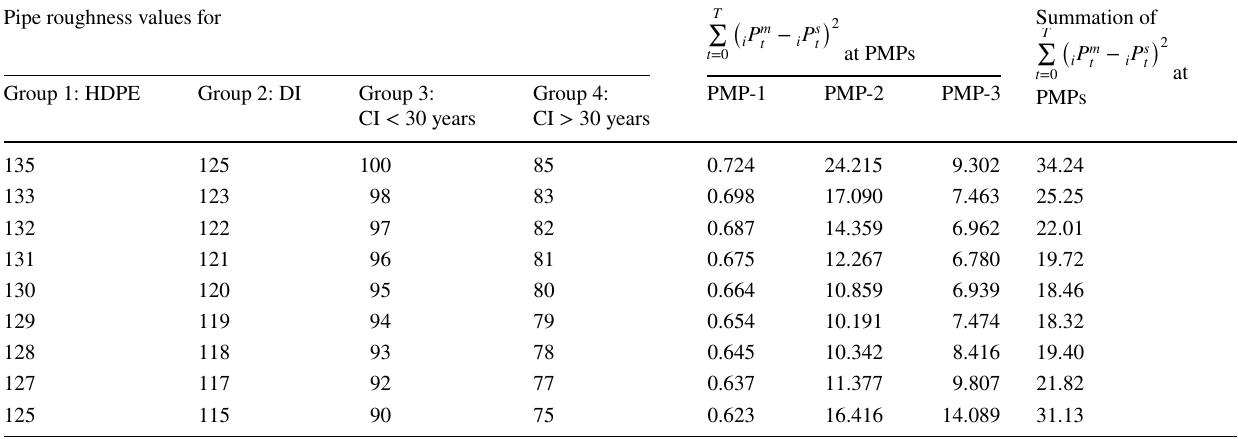
Table 4 Summation of sum of square of difference between the measured and simulated pressure heads Pipe roughness values